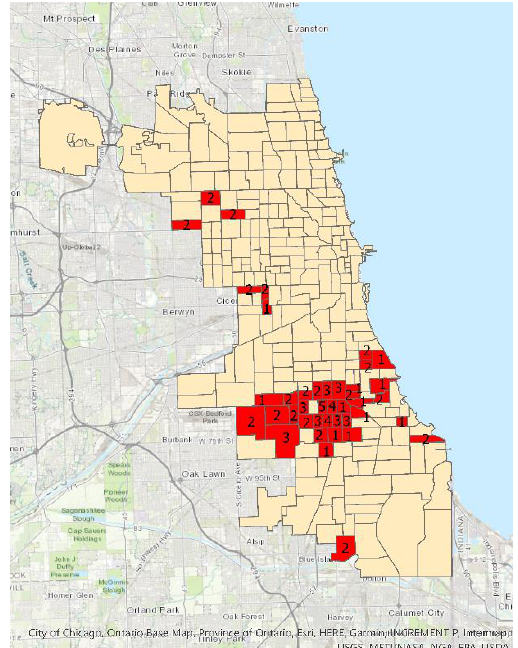
Figure 12. High value clusters by month at police beat level